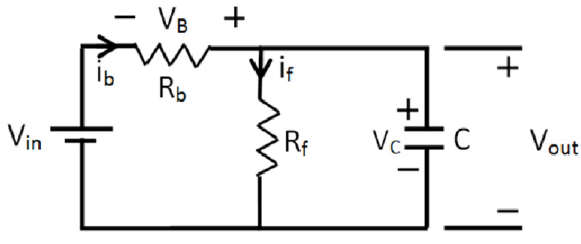
Figure 5. The analogous electrical circuit for reversible